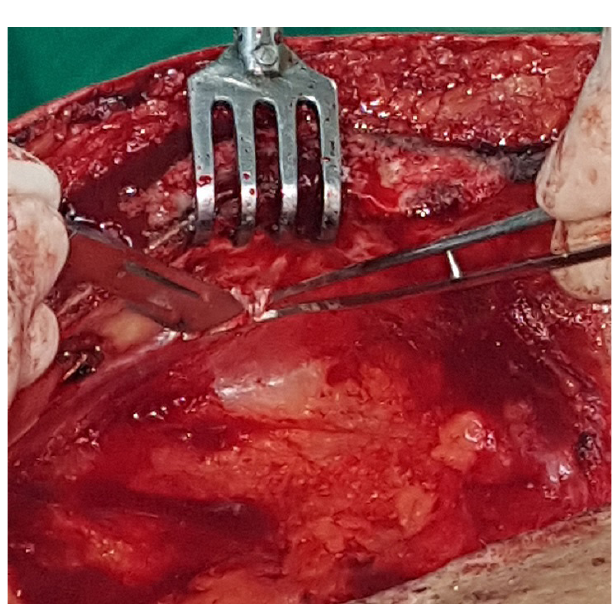
Fig. 1 -Opening of the endothoracic fascia covering the distal segment of the left ITA. The use of a scalpel facilitates the maneuver.